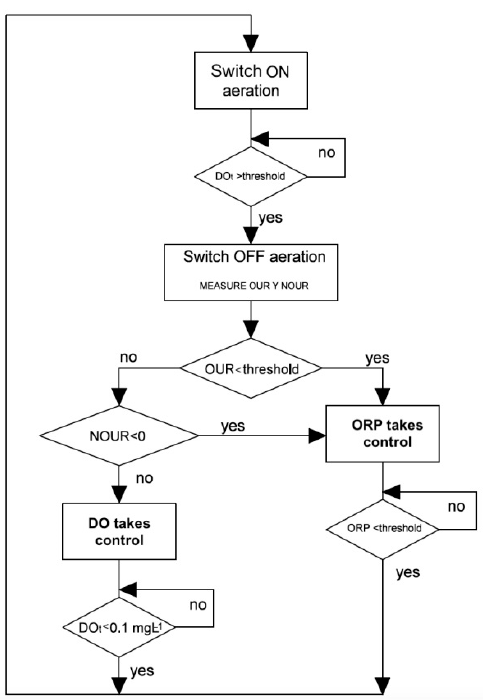
Figure 1. Description of the aeration control where DO, ORP, OUR and NOUR are used to manage the organic matter in the vessel.